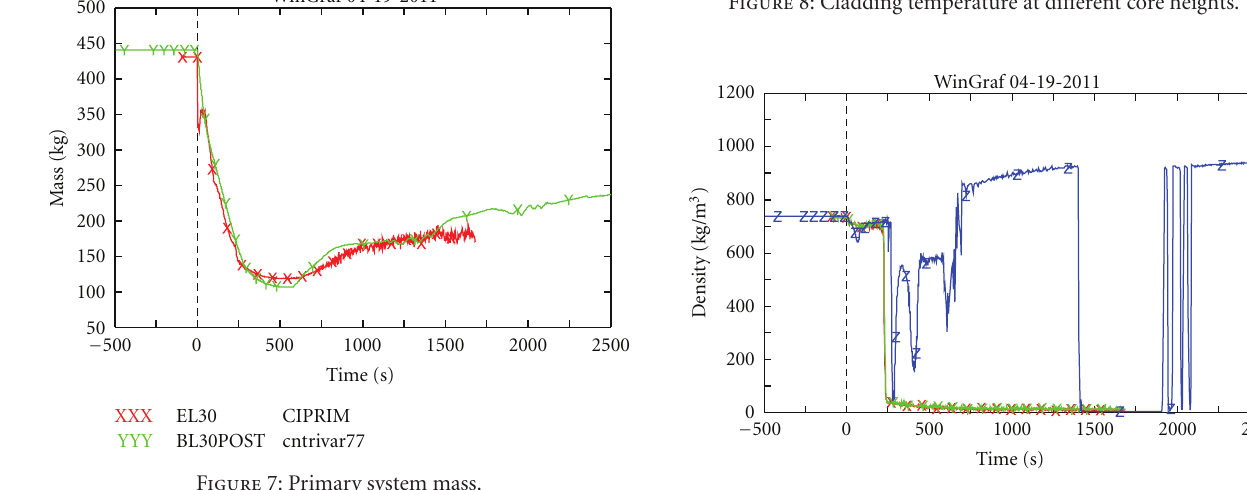
Figure 8: Cladding temperature at di ff erent core heights.